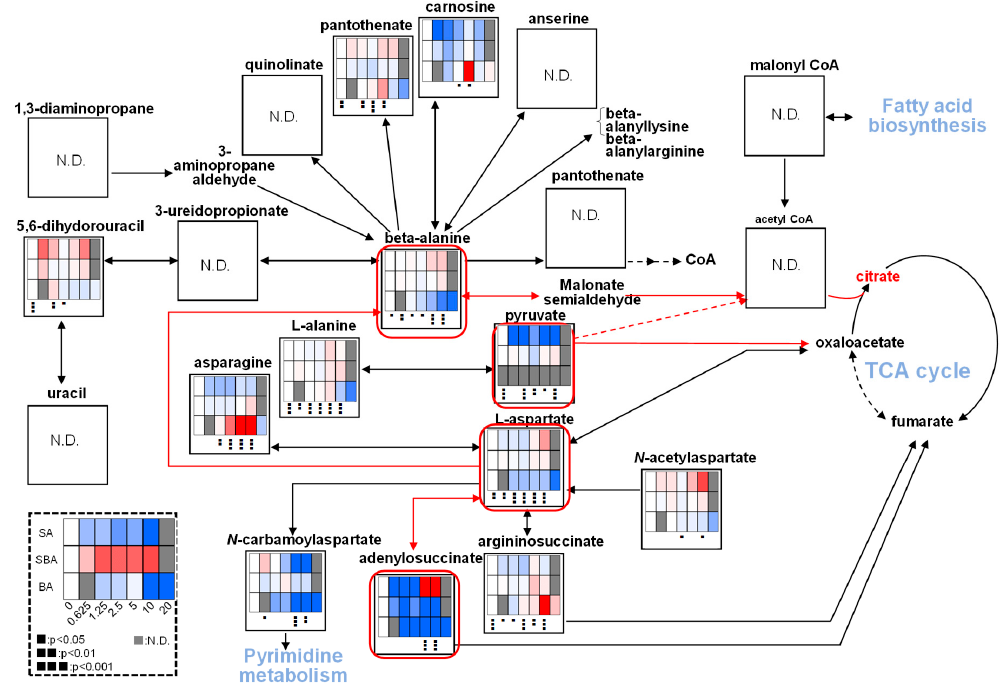
Figure 6. Possible pathway that reduces the supply of citrate by BA. SBA (60 min), BA (90 min), SA (30 min). The procedures used to produce heat maps and statistical analyses were described in Figure 5A.